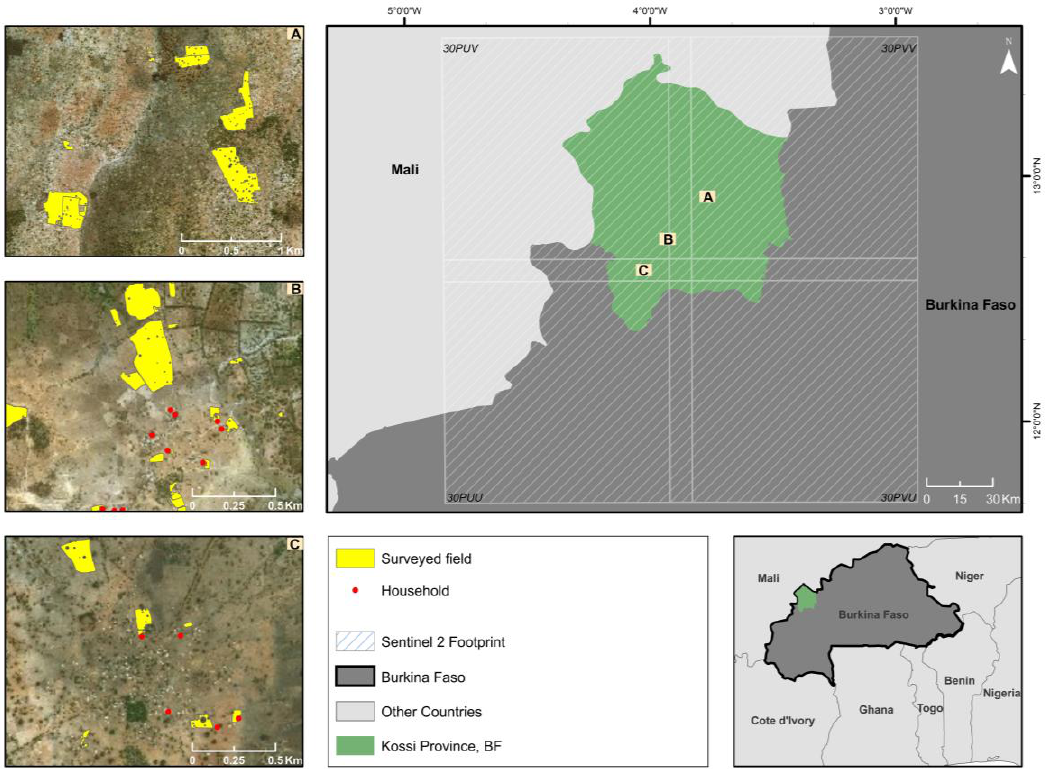
Figure 1. Study area overview with cutouts A, B, and C of surveyed fields and individual households (Environmental Systems Research Institute (ESRI) Basemaps).